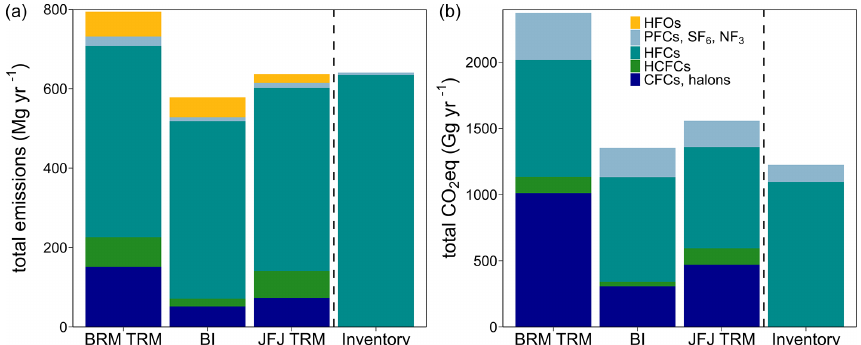
Figure 5. The total Swiss emissions (a) and the corresponding CO 2 equivalents (b) for 2019/2020, categorized by substance classes, i.e. chlorofluorocarbons (CFCs) and halons, hydrochlorofluorocarbons (HCFCs), hydrofluorocarbons (HFCs), perfluorocarbons (PFCs), NF 3 , SF 6 , and hydrofluoroolefins (HFOs), for the Beromünster (BRM) and Jungfraujoch (JFJ)-based tracer ratio method (TRM) results, the Bayesian inversion (BI) results, and the Swiss national inventory. The Swiss inventory only reports emissions for the HFCs, PFCs, NF 3 , and SF 6